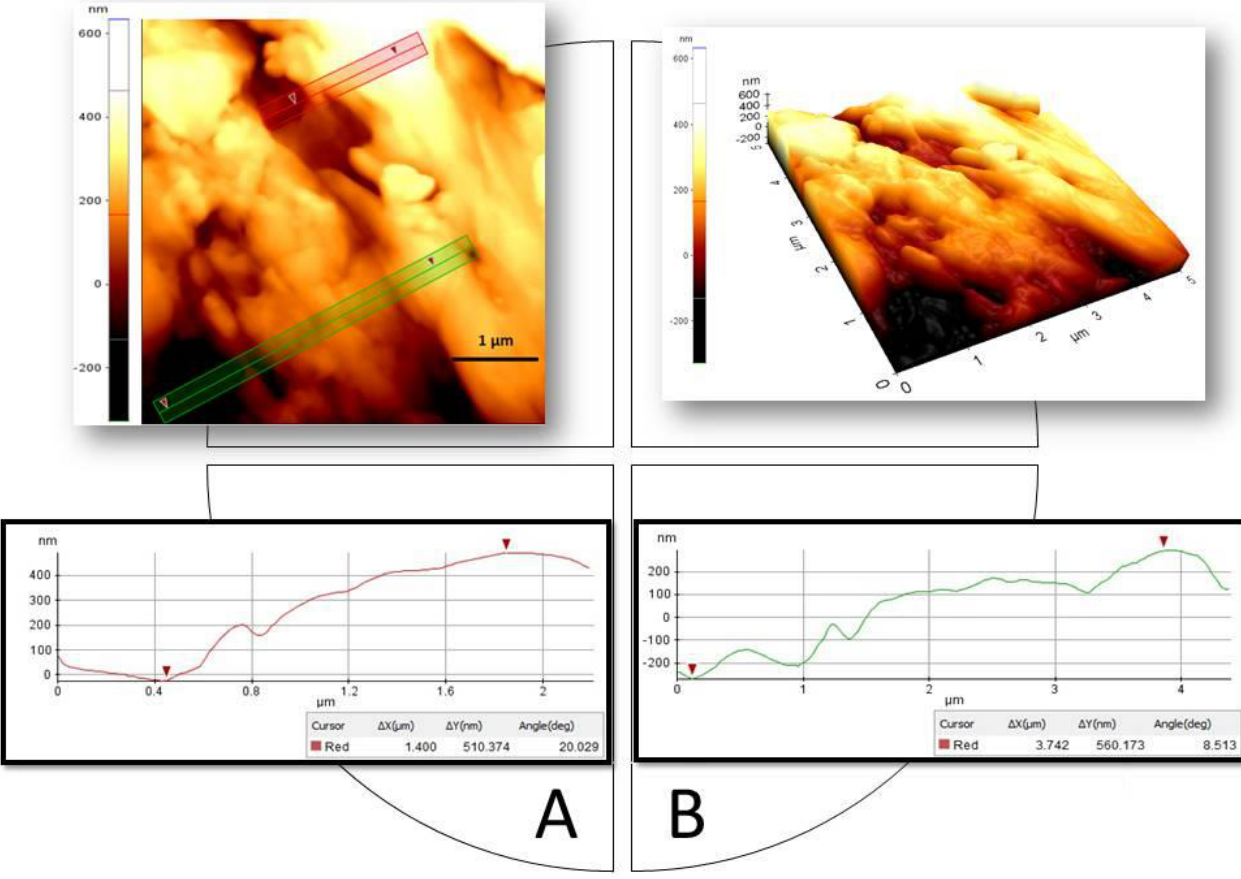
Figure 7. Topographic images of the Atomic Force Microscope (AFM) in trace of the probe. At left viewpoint vertical to the image and, at right, and oblique view. The two plots below show topography for two regions: ( A ) refers to the red scale of the image, and ( B ) refers to the green scale of the image.